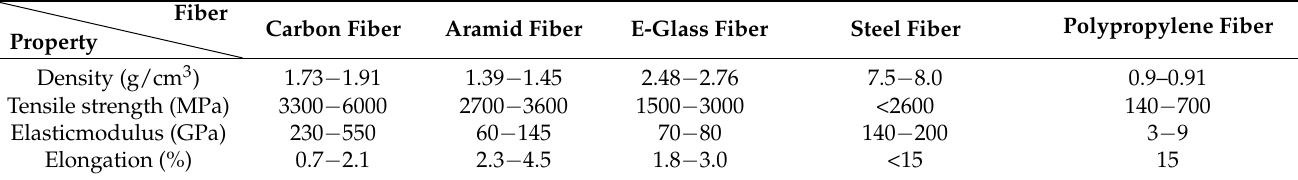
Table 1. Material properties of various